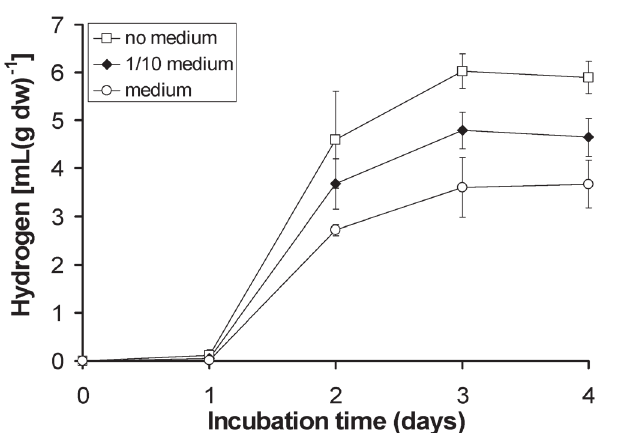
Fig 4. Kinetic of hydrogen production of the lichen Pleurosticta acetabulum in several culture